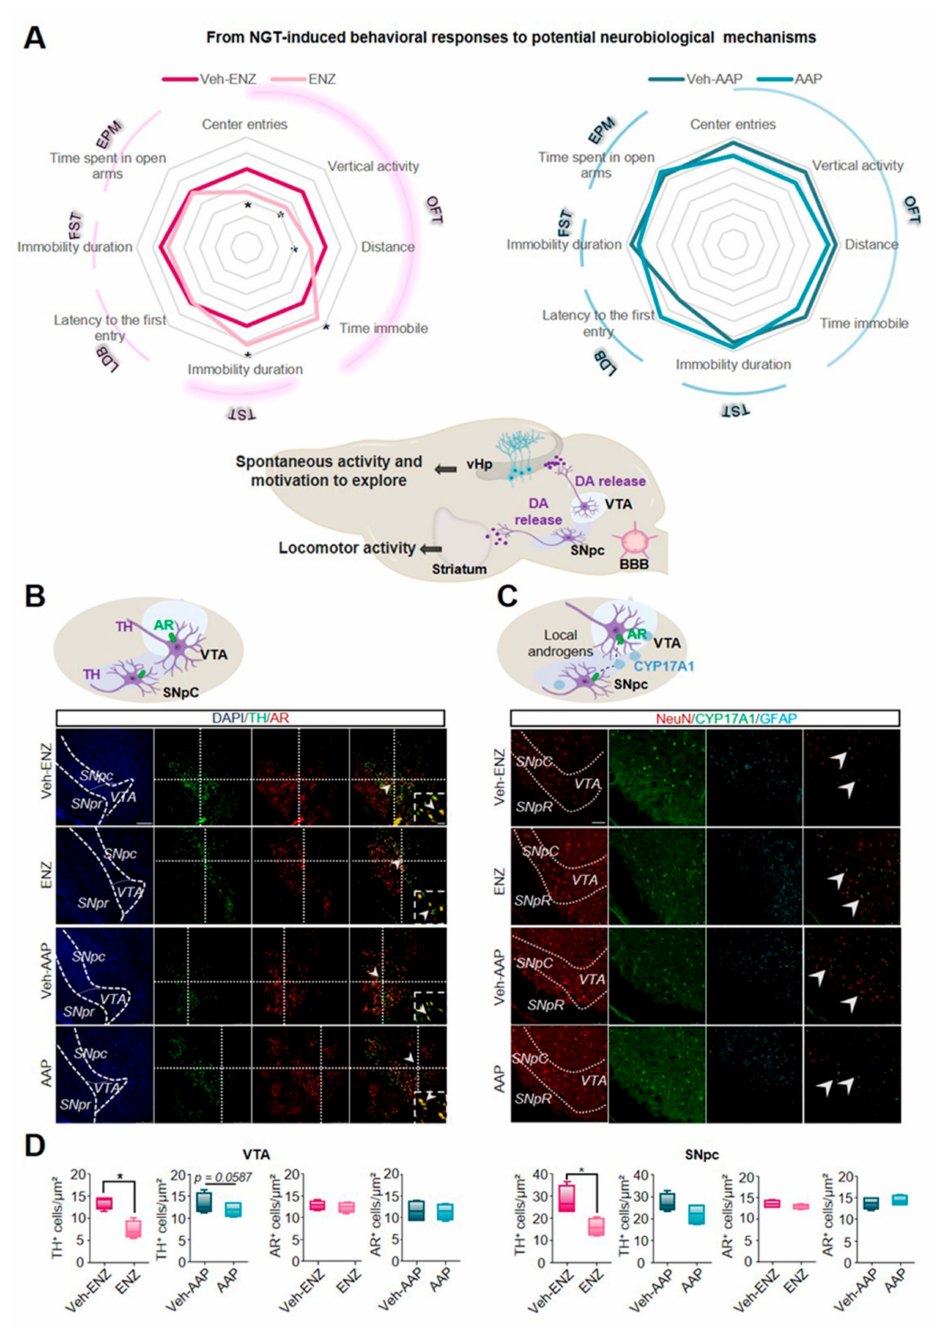
Figure 3. AR and CYP17A1 are expressed in the substantia nigra pars compacta and ventral tegmental area and ENZ inhibits dopaminergic activity in both midbrain nuclei. Note. ( A ) Comparative Radar Chart of performance index scores across emotional and exploratory behavioral domains after ENZ ( left panel ) or AAP ( right panel ) treatments compared with Vehicles as presented in Figure 2A and Table S3. Based on the behavioral modifications, schematic representation (Middle panel) of nigrostriatal and corticolimbic circuits potentially involved in ENZ-altered locomotor activity and exploration. Based on previous studies, AR may be expressed in ventral tegmental area (VTA) and substantia nigra pars compacta (SNpc) dopaminergic neurons. SNpc projects dopamine (DA) axons to the striatum (nigrostriatal pathway) while VTA projects DA axons to ventral hippocampus (vHp) (corticolimbic pathway), also expressing AR. Statistical analysis was done on performances of vehicle ( n = 14) and treated ( n = 16) mice using unpaired t -test or Mann–Whitney test; Data are mean ± SEM; * p ≤ 0.05. ( B ) Schematic drawing of SNpc and VTA dopaminergic neurons expressing AR.